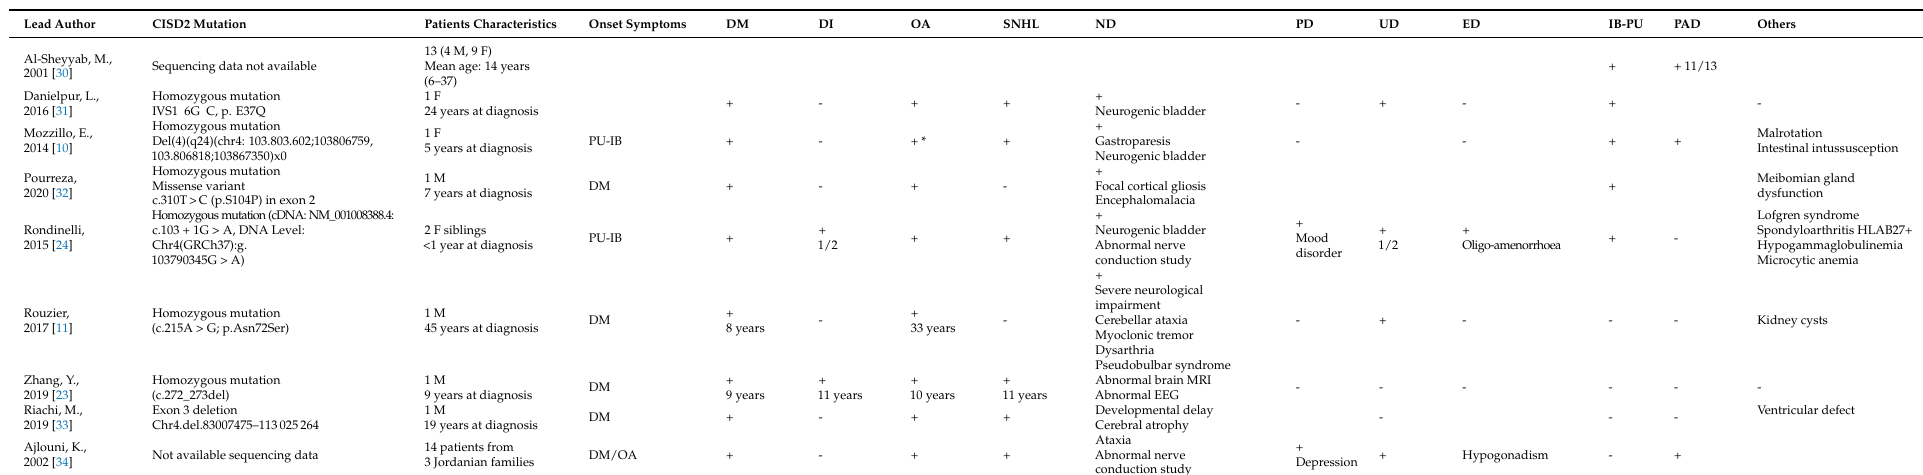
Table 1. Major clinical features of Wolfram syndrome type 2 described in the